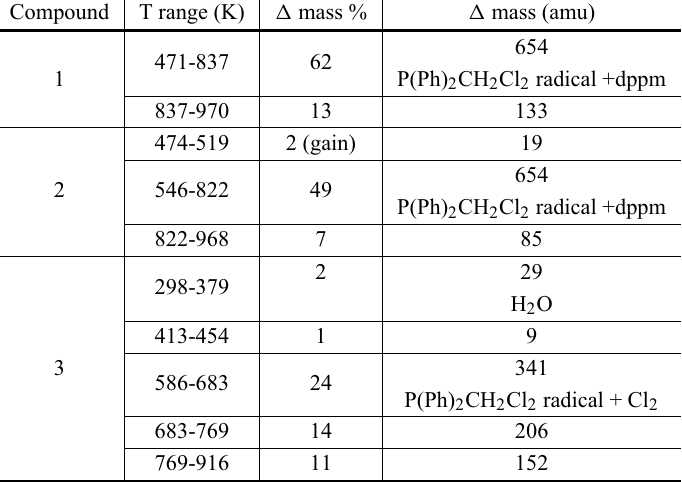
Thermogravimetric data for compounds 1-3 .